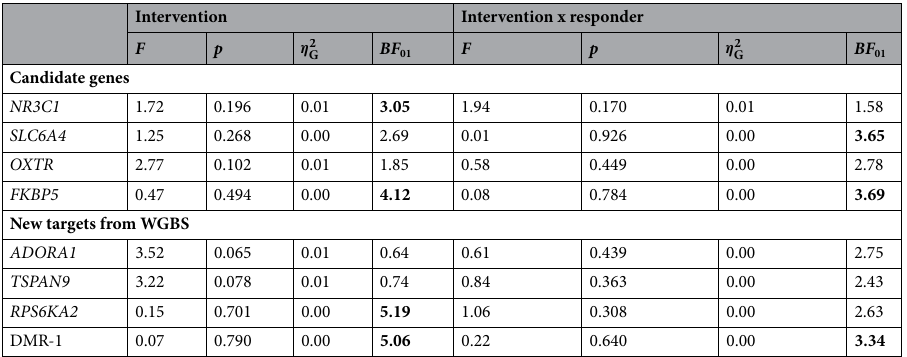
Table 1. Effect of intervention and the effect of intervention by responder status interaction on DNA methylation. Results from a mixed model analysis of variance. ƞ 2 G = generalized eta squared. BF 01 = Bayes factor quantifying the evidence for the null hypothesis against the alternative hypothesis. Bayes factors above 3 are interpreted as substantial evidence for the null hypothesis and shown in boldface. Numerator df = 1 for all tests. Denominator df for NR3C1 = 51 and for RPS6KA2 = 54 due to missing values. For all other genes denominator df = 55.